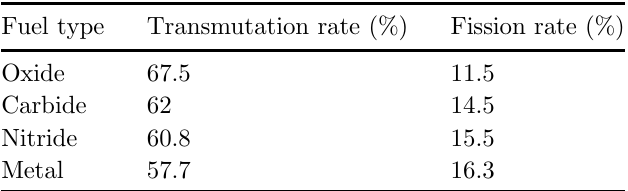
Table 2. Minor actinides isotopic vector. Element